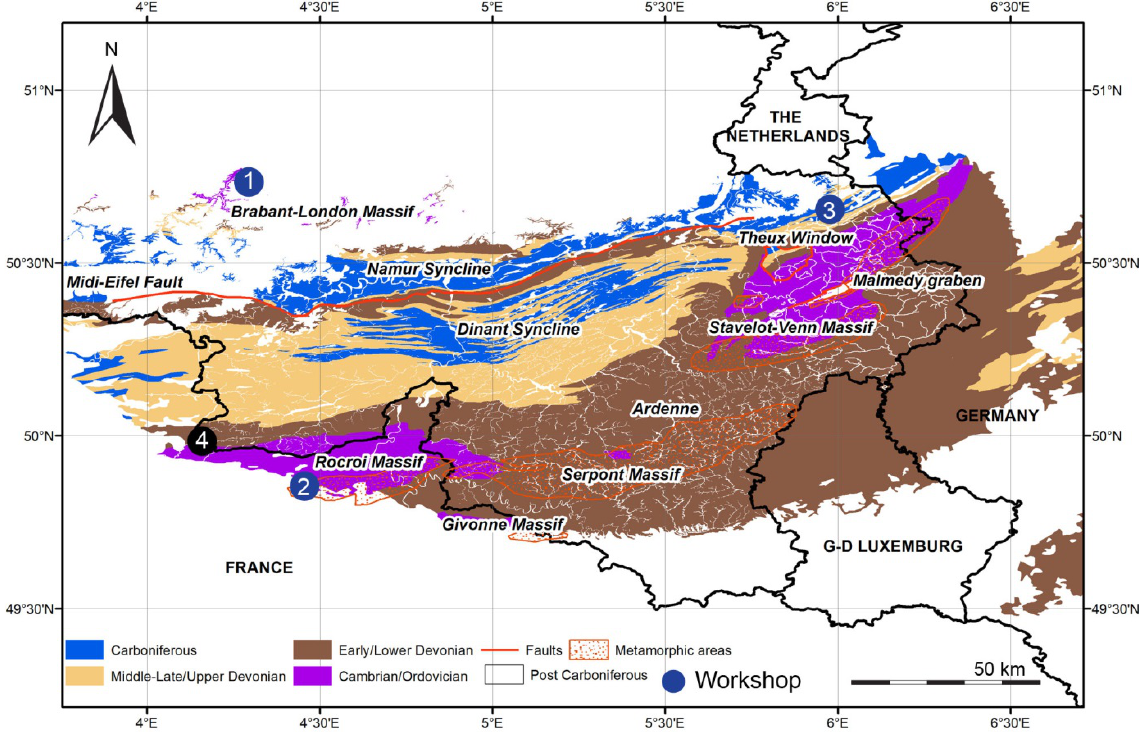
Figure 3: Geological map with the three workshops: (1) Buizingen, (2) Le Châtelet-sur-Sormonne, (3) Nereth and the millstone quarries of (4) Macquenoise and (in purple) the Lower Palaeozoic inliers. Map modified after Goemaere et al . (2015). The borders of the metamorphic areas are adapted from Fielitz & Mansy